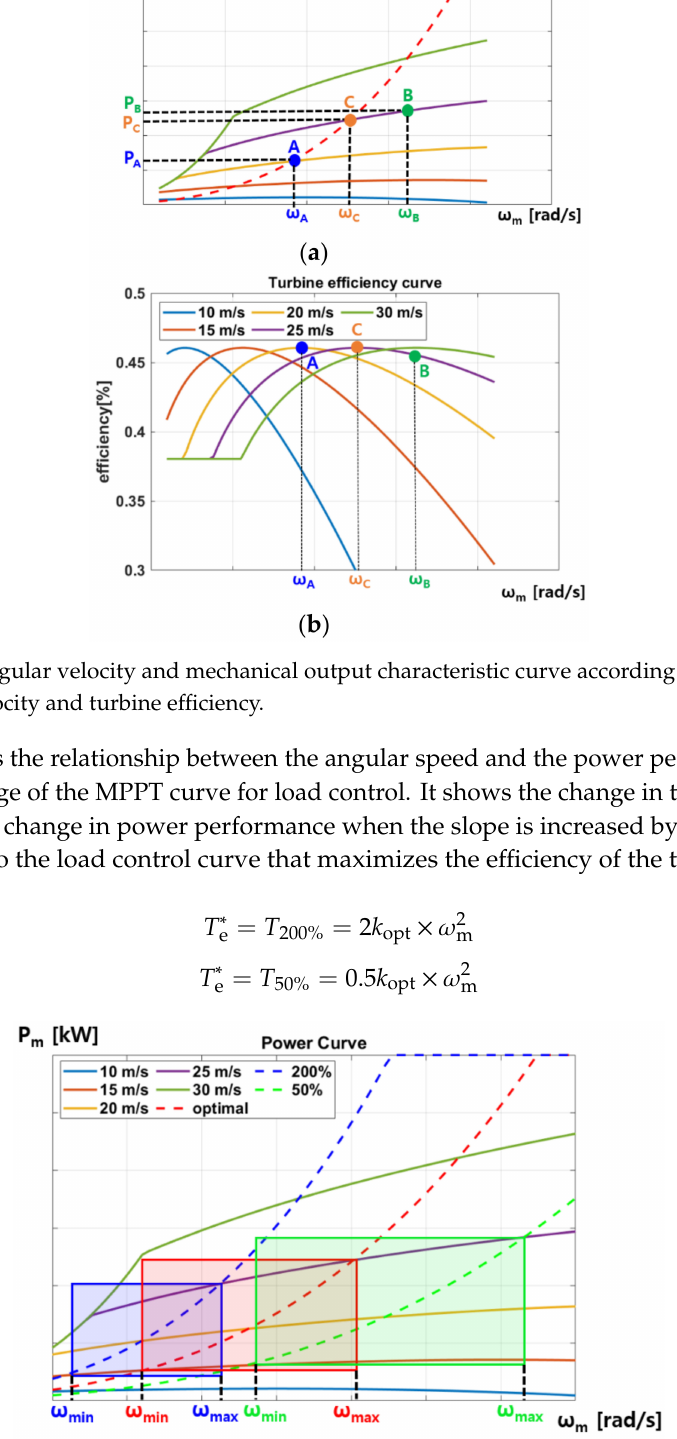
Figure 9. Relationship between angular speed and power generation according to the coe ffi cient change of the MPPT